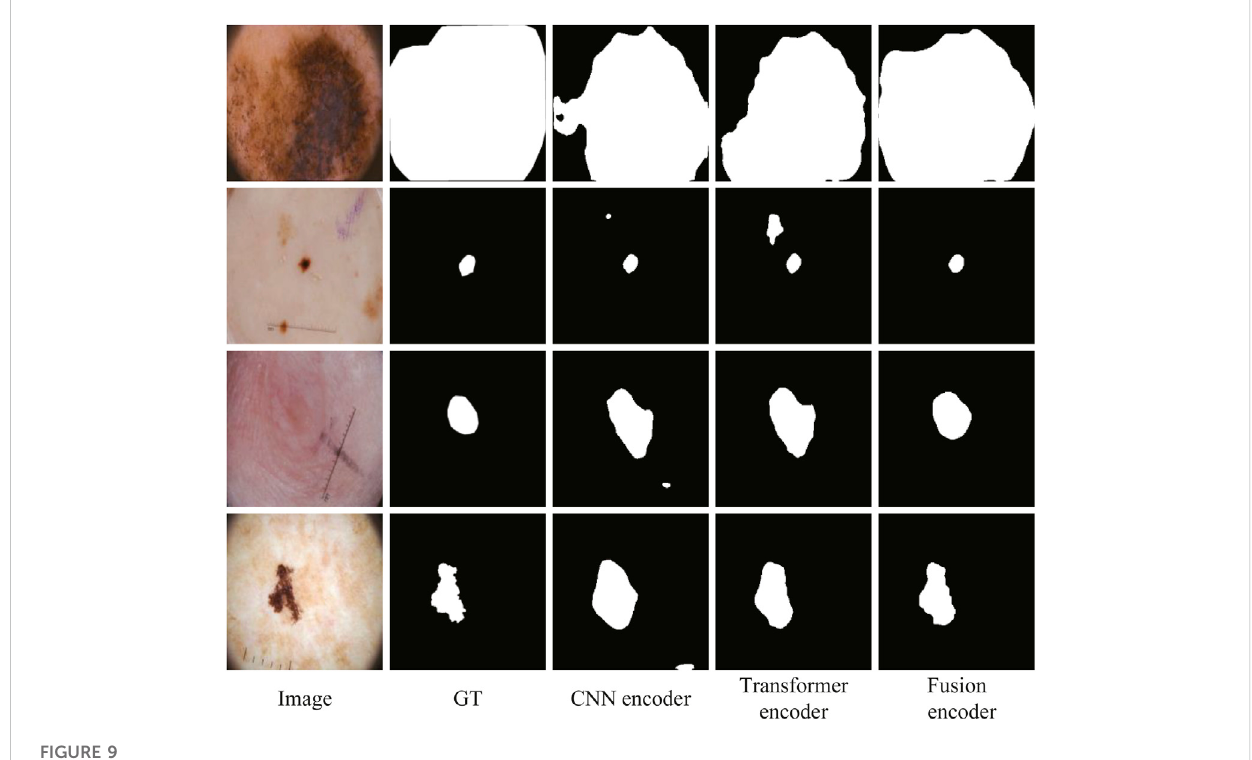
FIGURE 9 Qualitative comparison for the ablation study on the